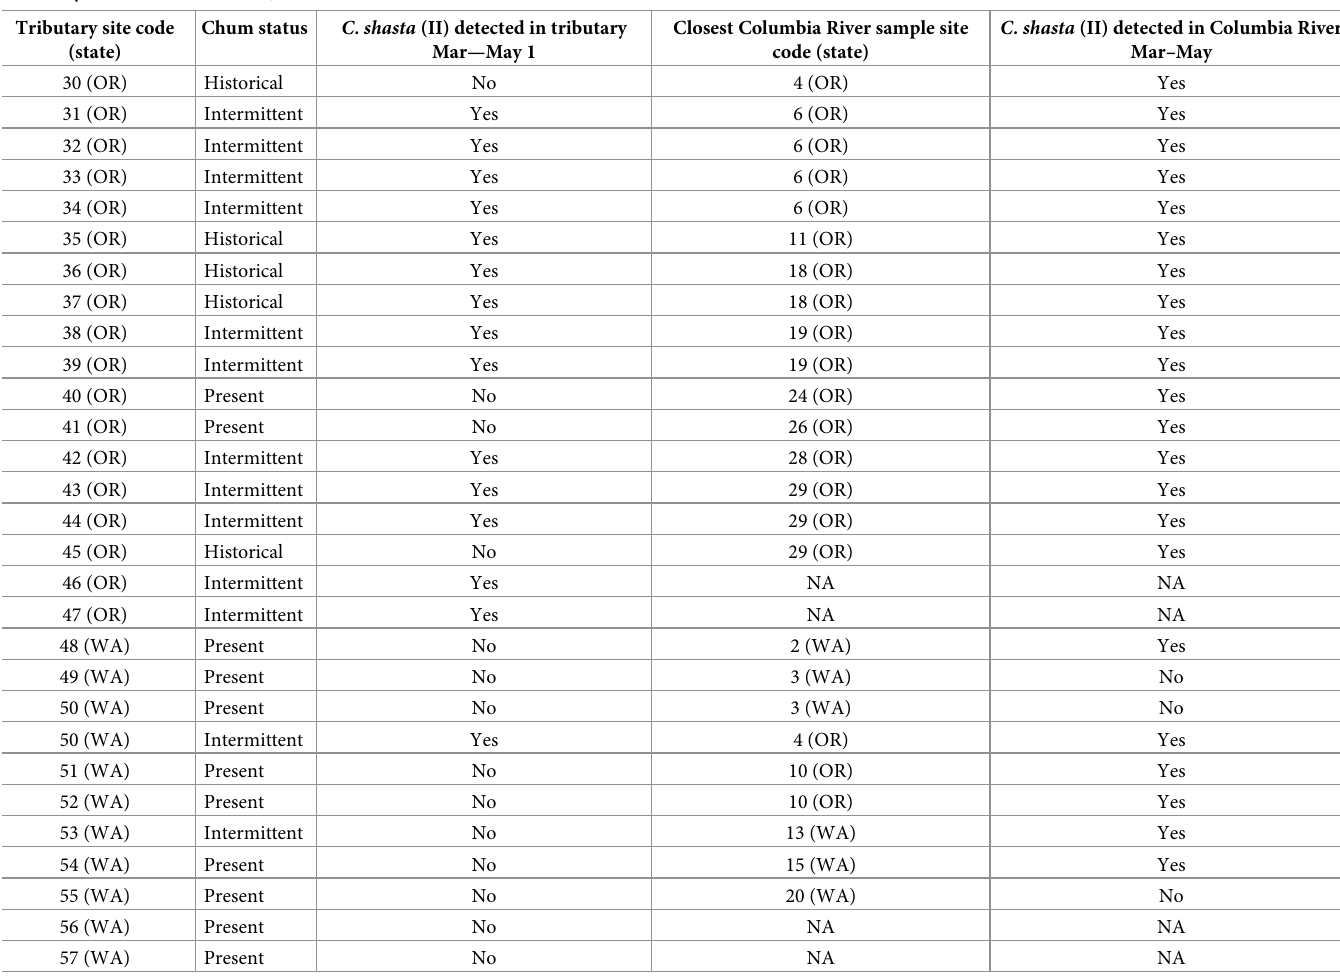
Table 5. Site code (state), chum salmon Oncorhynchus keta spawning status (historically present, intermittently present, or consistently present), and presence of Ceratonova shasta genotype II in tributaries and the closest Columbia River sample sites during the season when juveniles are present (Mar–May 1 in tributaries, Mar–May in the Columbia River), 2018–2020. Tributary site code